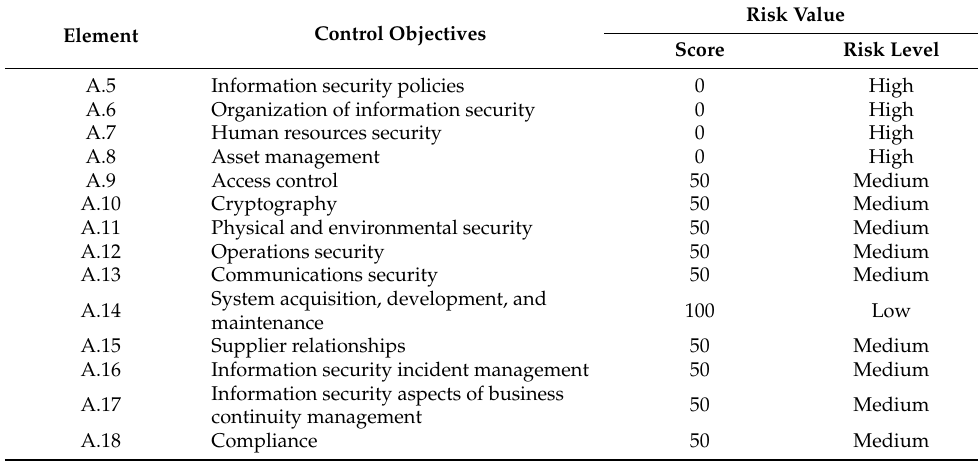
Table 5. Risk Level of Audit Findings Control Risk Treatment Plan Network